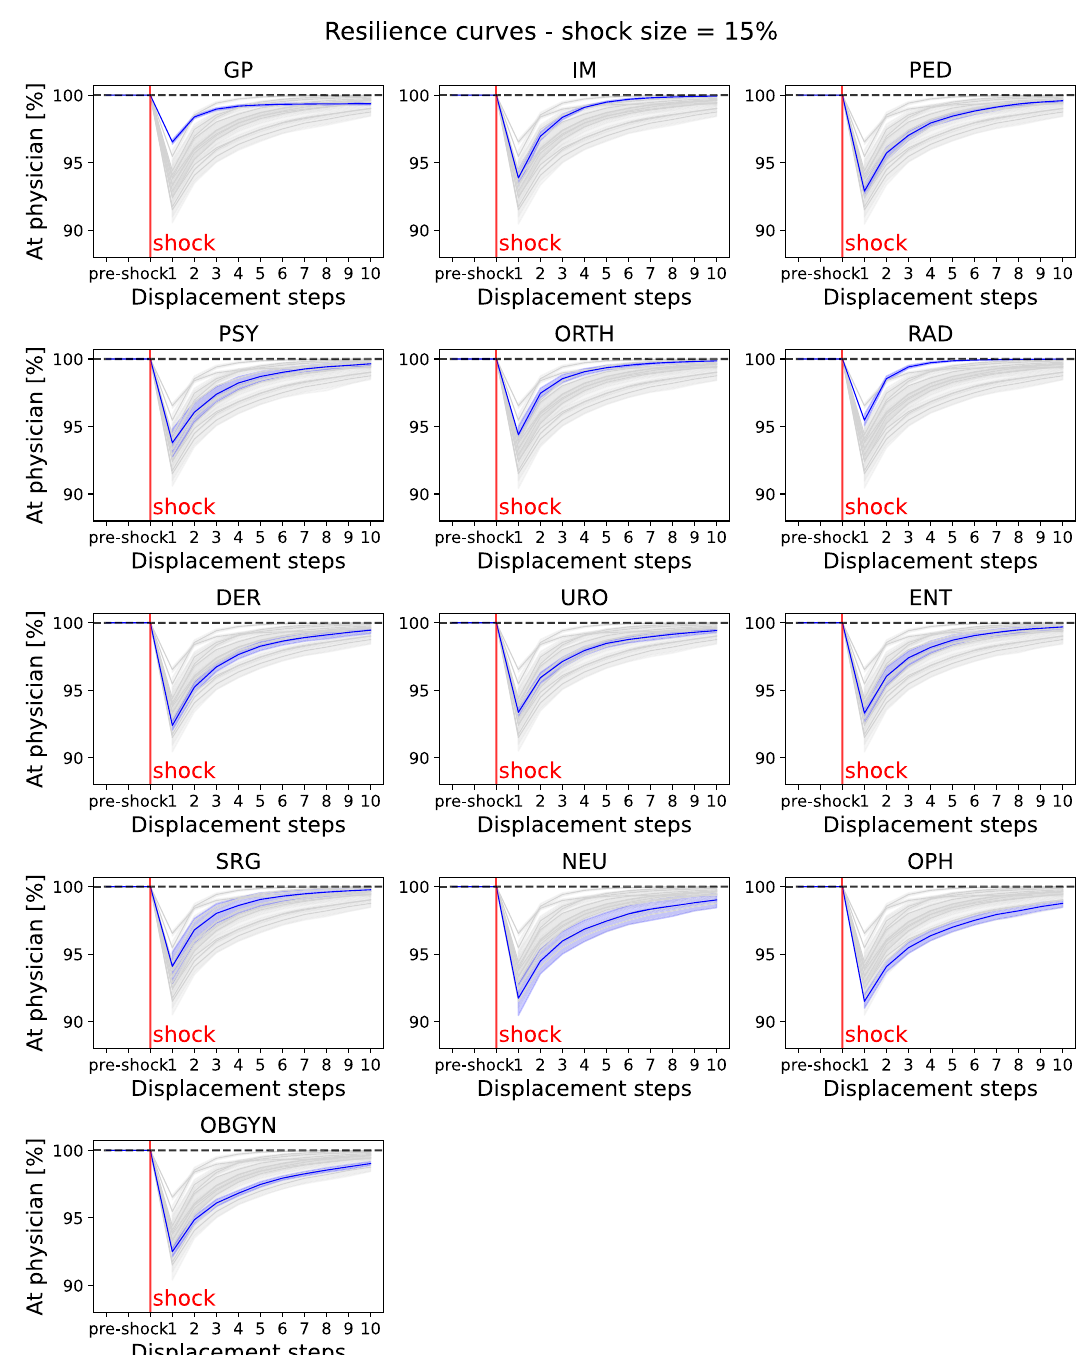
Fig. 5 Large-scale unavailability event. Individual panels show resilience curves for each specialty (for a list of abbreviations of specialists see Table 1). The curves show the number of patients that have a physician over ten displacement steps after a single large shock where 15% of randomly chosen physicians of the given specialty were removed simultaneously. Single plots highlight one specialty while others are shown in grey for comparison. Lines and error bands display mean and standard deviation over an ensemble of ten simulations. The dashed black line represents no patients on active lookout for a new